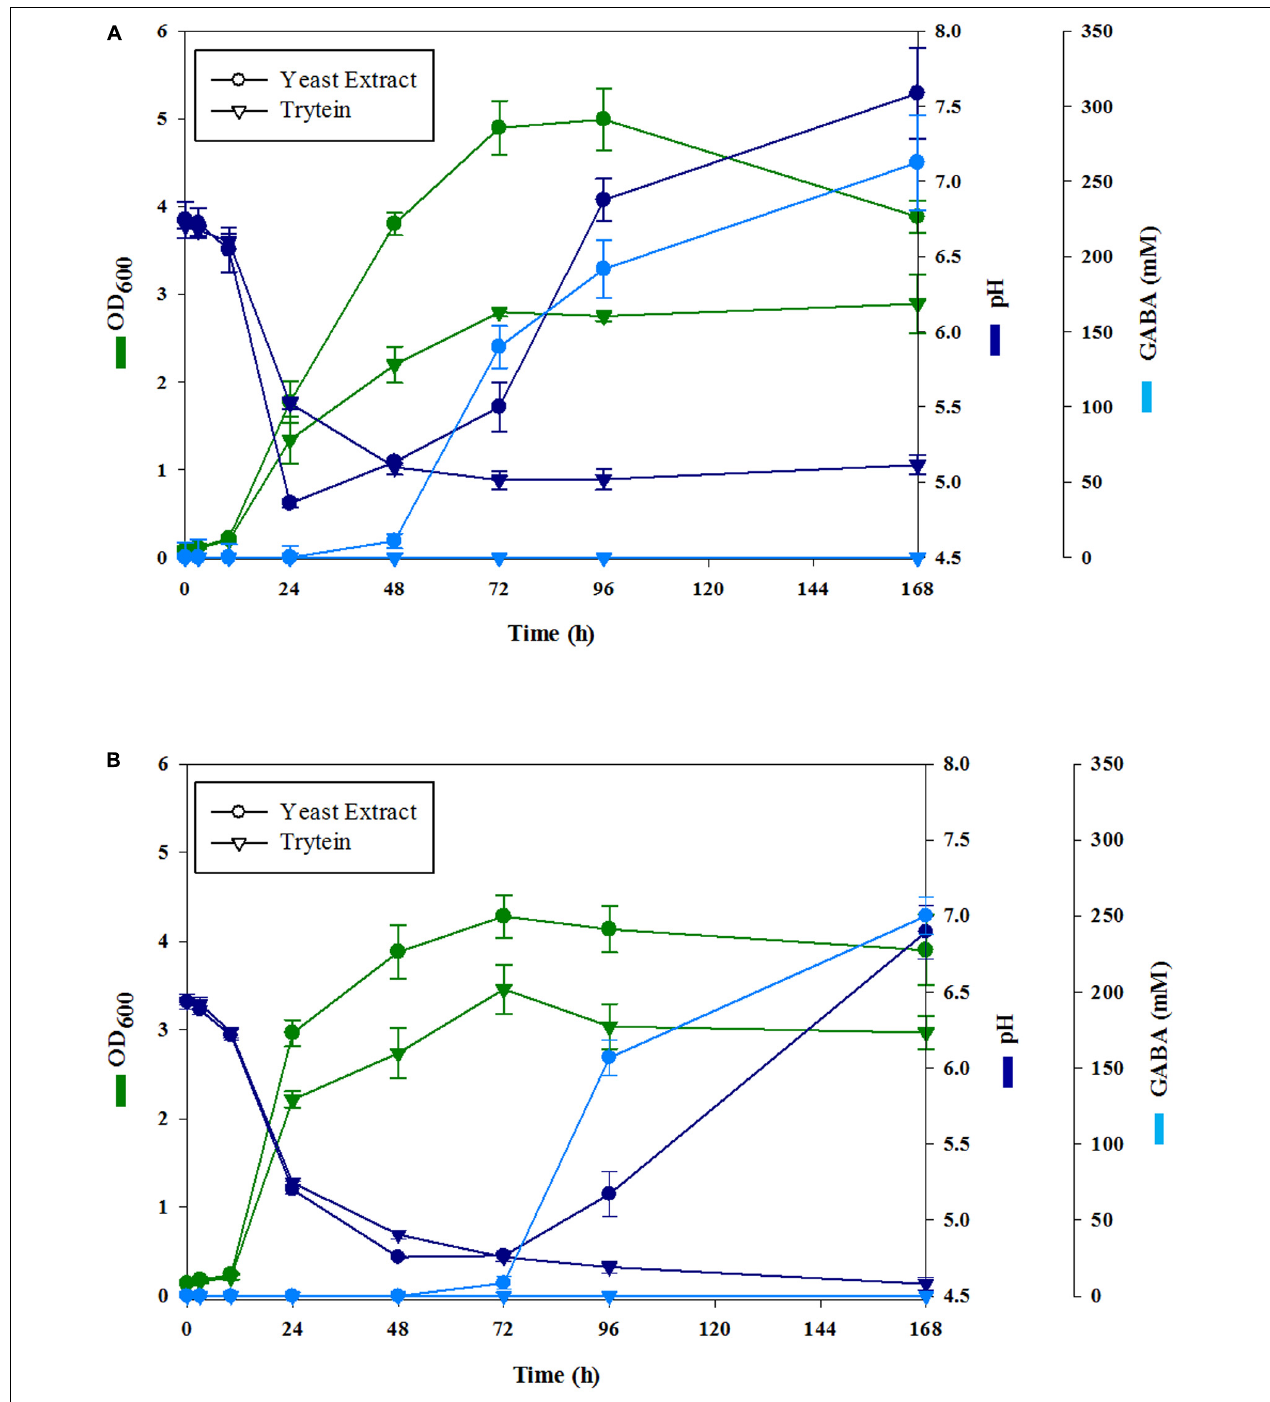
FIGURE 1 | Cell growth (green lines), pH (blue lines), and GABA production (cyan lines) by L. brevis CRL 2013 in MSG strawberry (A) and blueberry (B) juices supplemented with yeast extract ( • ) or tryptein ( (cid:72) ) at an initial pH of 6.5. Cell growth is expressed as ln x/x0, where x0 is initial biomass, and x is biomass at the indicated time. All values are means ± standard deviations from at least three separate